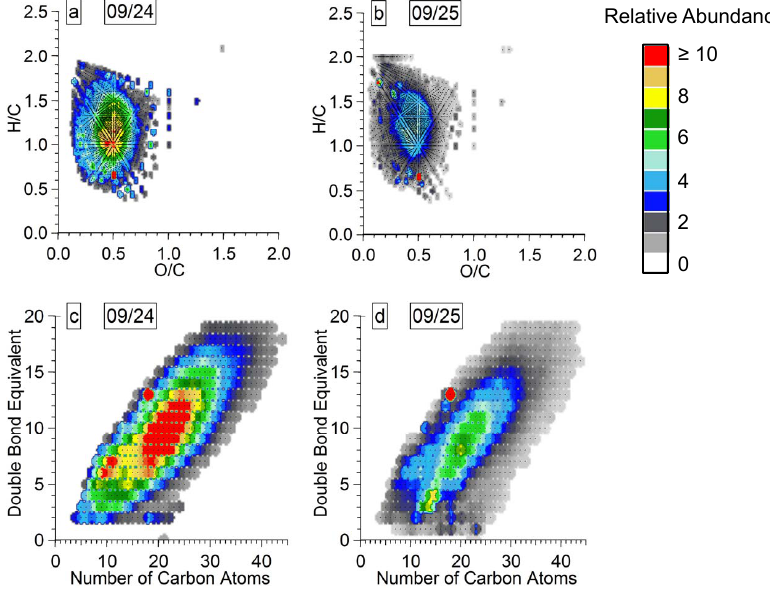
Figure 7. CHO isoabundance van Krevelen diagrams of 9 / 24 (a) and 9 / 25 (b) with all detected individual ions shown as dots to facilitate visualization of CH 2 homologous series. Also shown are the double bond equivalents vs. the number of carbon atoms of the 9 / 24 (c) and 9 / 25 (d) for the CHO group with symbol colour representing the relative